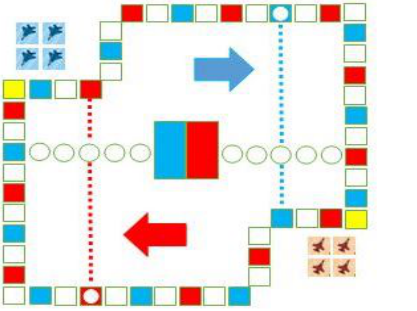
Figure 1. The chessboard of the Chinese Ludo